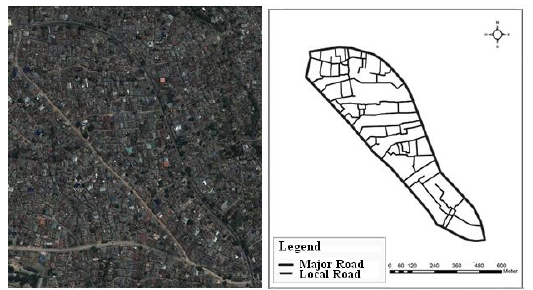
Figure 6. Satellite Image (Left), Transport Infrastructure Map (Right); Manzese, Dar es Salaam,